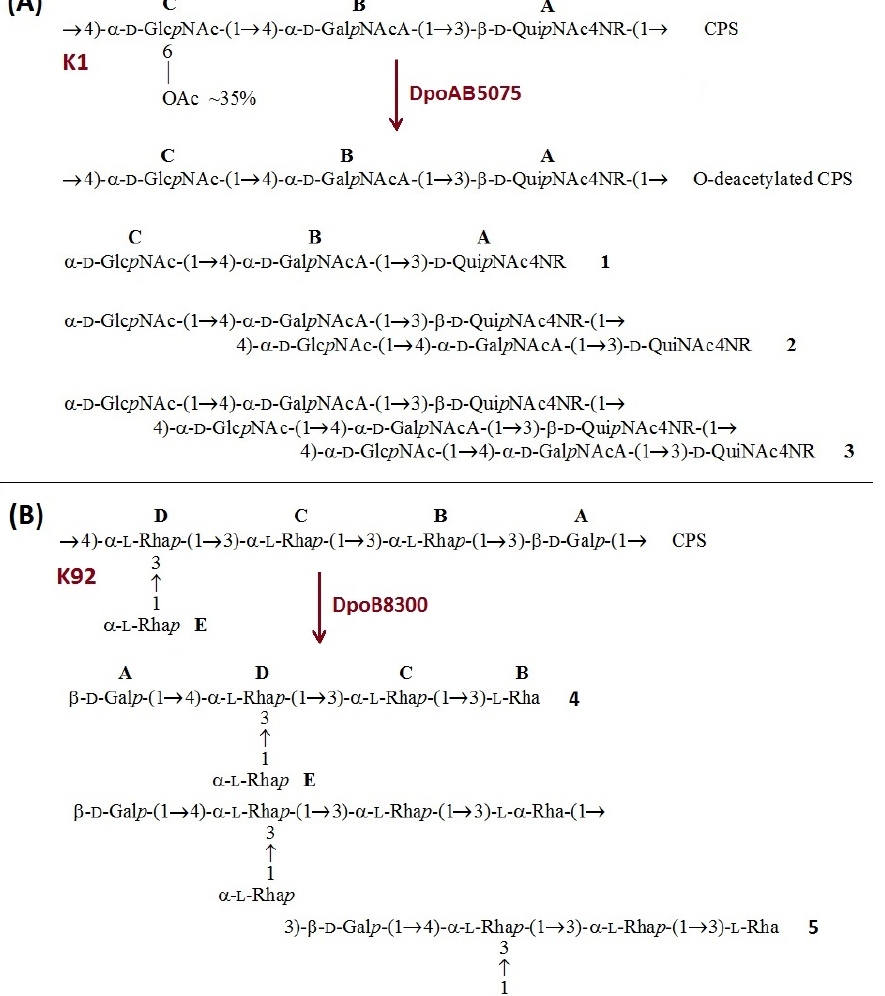
O-deacetylated CPSs were studied.